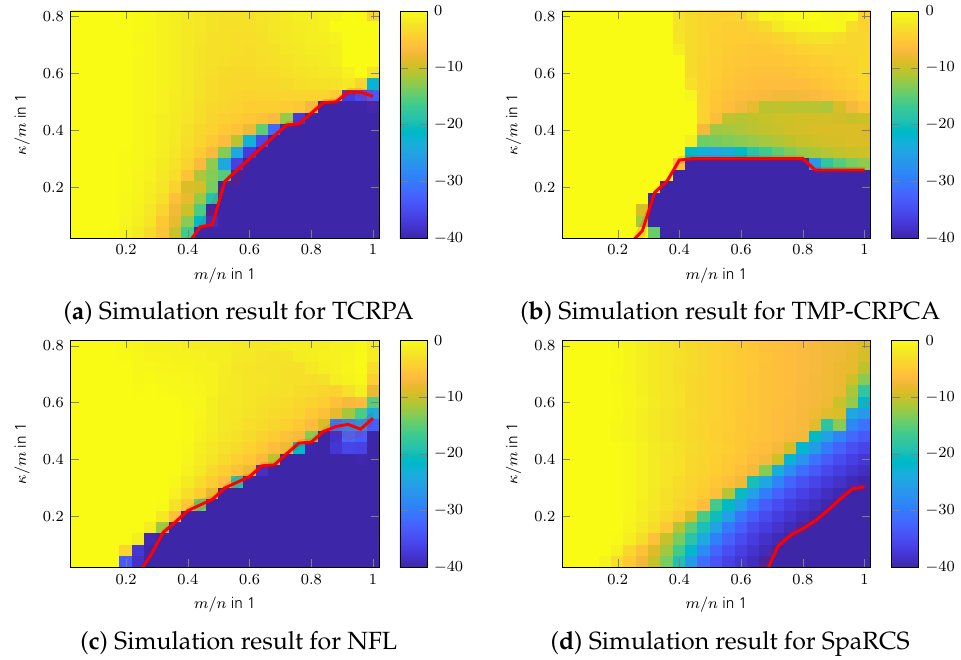
Figure 17. In detail reconstruction performance comparison for a DFT sensing operator and ρ = 9. The red line indicates the success boundary or the phase transitions shown in Figure